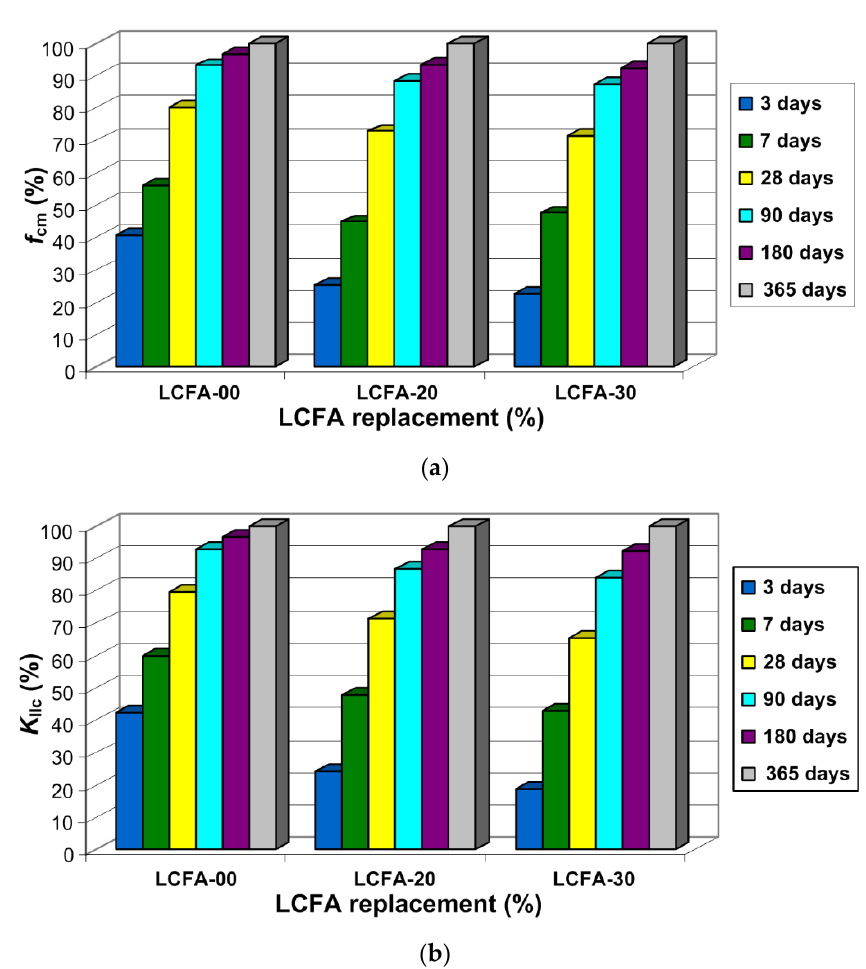
Figure 9. Relative changes of the analyzed parameters over time: ( a ) compressive strength; ( b ) fracture toughness at shear.